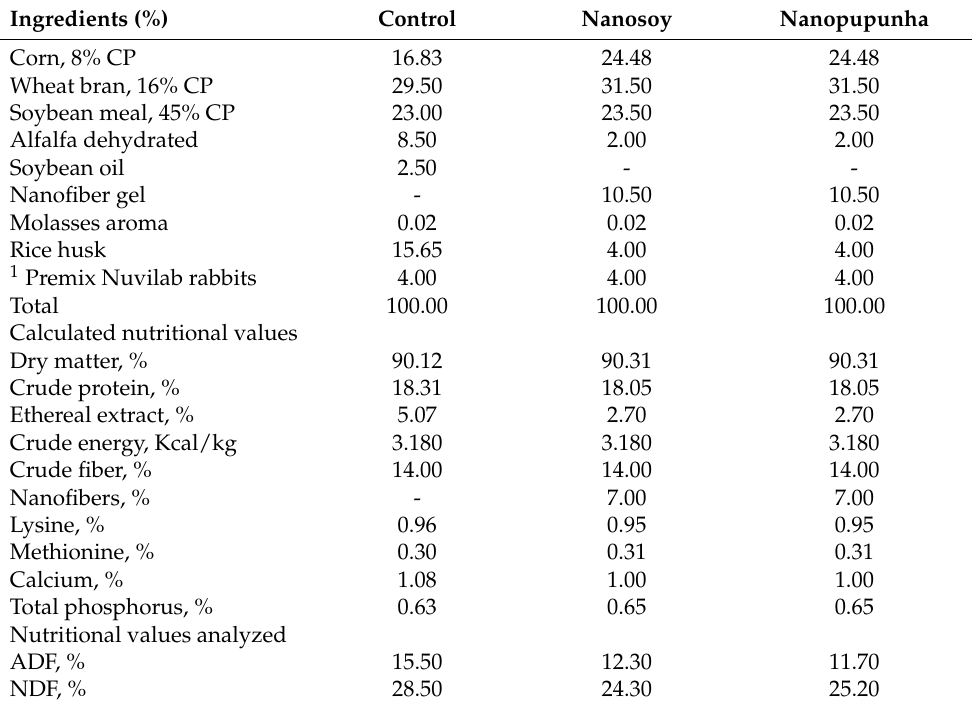
Table 1. Compositions and the calculated and analyzed nutritional values of the three experimental diets fed to growing